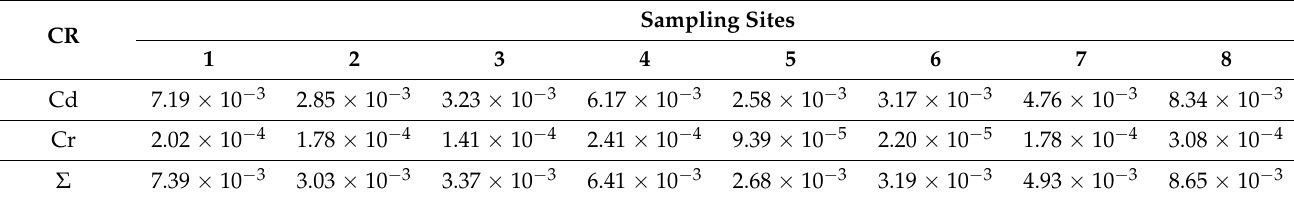
Table 4. The results of the carcinogenic risk assessment.